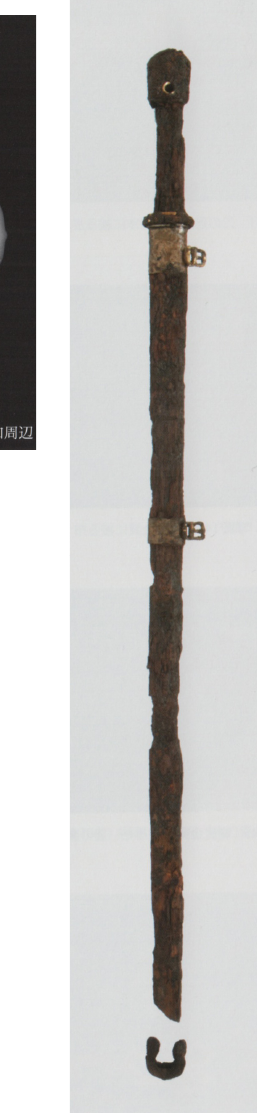
Figure 9. Yang Sword ( yōken ; left ) and Yin Sword ( yinken ; right ) and their inscriptions. Discovered from southwest side from beneath the Seated Vairocana Buddha. Daibutsuden, Tōdaiji. Nara period, mid 8th century. In the collection of Tōdaiji. Reproduced from Gangōji Bunkazai Kenkyūjo (2015), pp. 210, 213, 216, and 219.